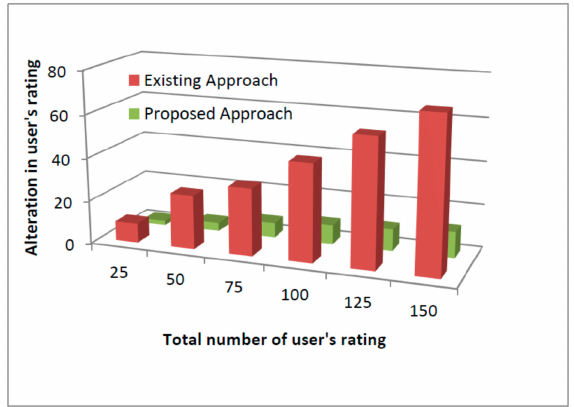
Figure 9. The attack possibility against compromised devices.